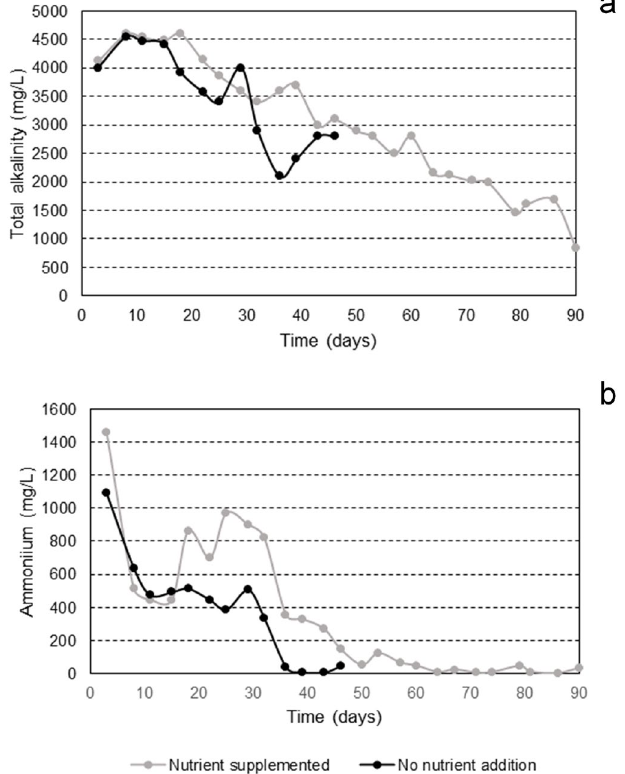
Figure 3. ( a ) Total alkalinity and ( b ) ammonium measurements from the reactor liquor during di- gestion of fourth-range wastes. Systems studied were supplemented with nutrients in one case and lacked nutrient addition in the other